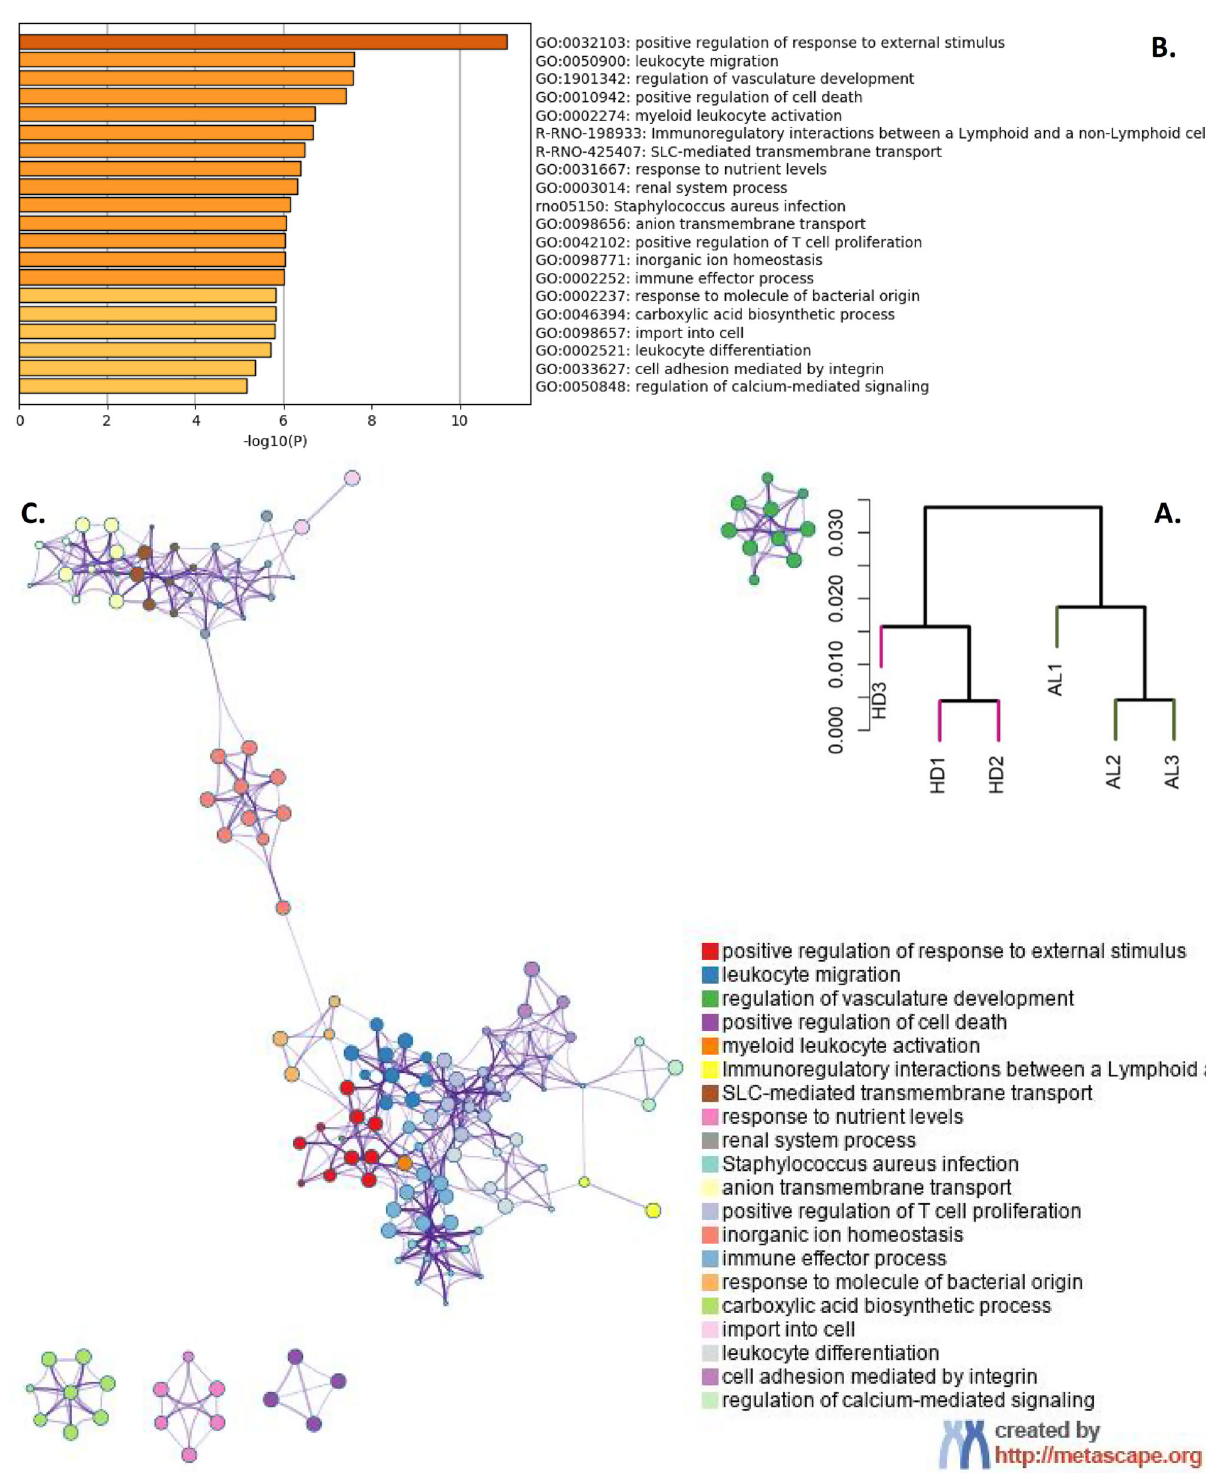
Fig. 3 Gene expression analysis. A Dendrogram of expressed genes. B Functional enrichment of the differentially expressed genes. The x axis represents − log10 of the P value. C Each node represents a functionally enriched term, where the size is proportional to the number of input genes that fall into that term, and the color represents cluster identity. Terms with a membership similarity >0.3 are linked by an